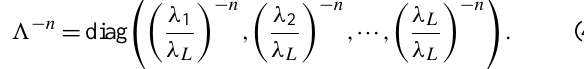
Fig. 9. Capon and MSR spectra for the synthetic data with two wave components that have similar or very close wavelengths (Narita et al.,